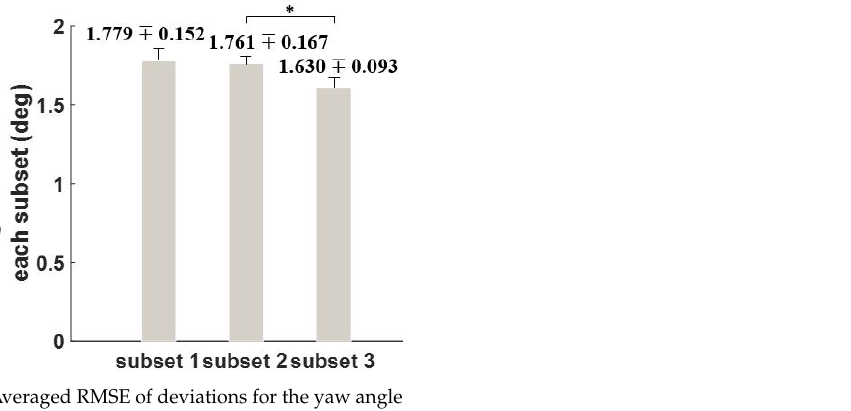
Figure 7. Analysis on RMSEs of Euler angle differences. * denotes the statistical